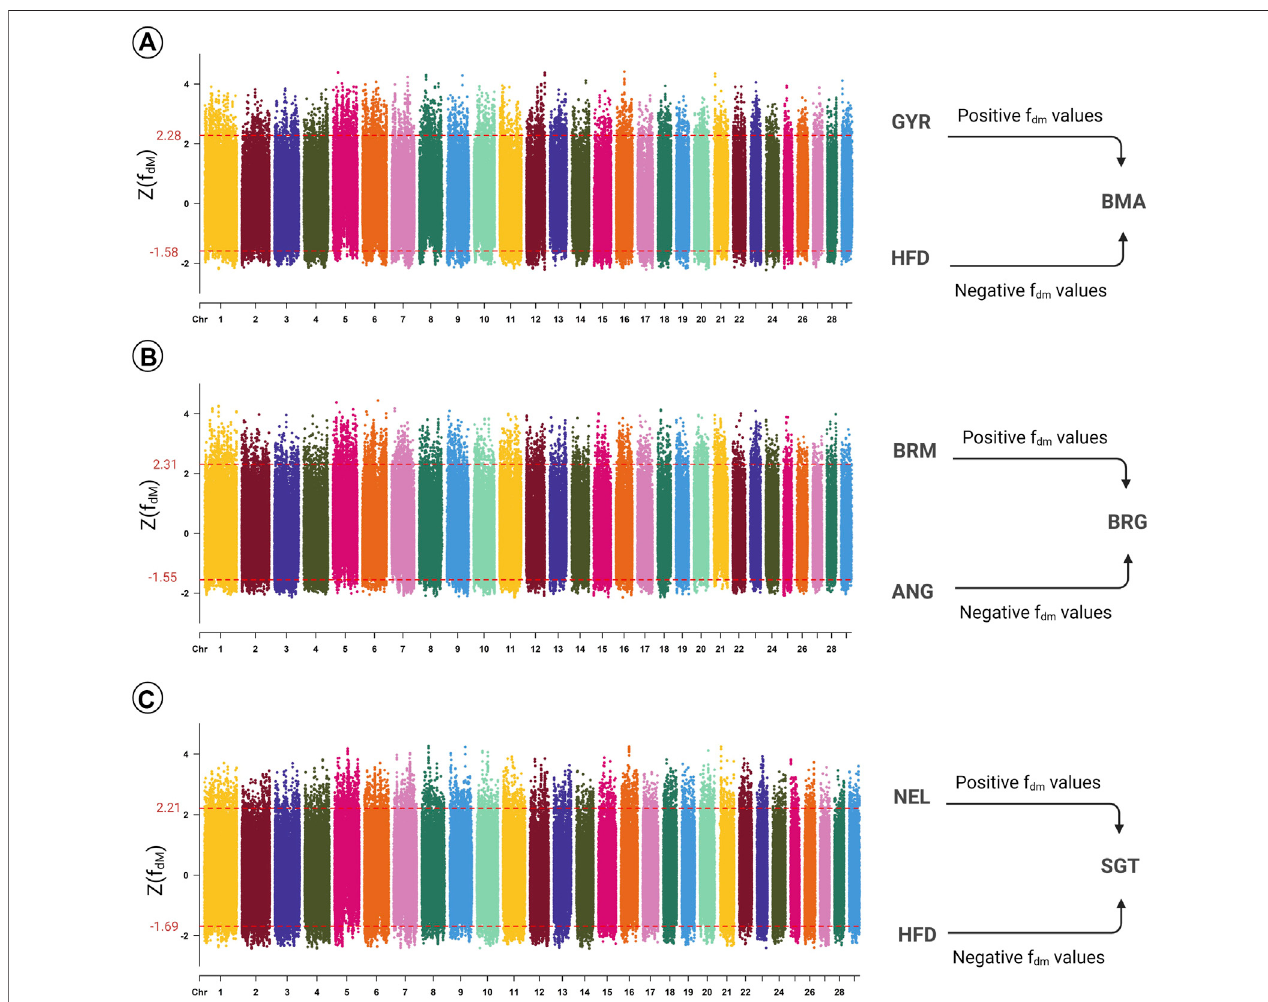
FIGURE2| ManhattanplotoftheZ-transformedf dM (Z(f dM ))atthesigni fi cancethresholdof5%inBeefmaster (A) ,Brangus (B) ,andSantaGertrudis (C) .Thef dM > 0represents regions with Indian Bos taurus indicus (IBI) ancestry, while f dM < 0 represents regions with European Bos taurus (EBT) origin. Abbreviations of all breeds are given in Table 1 .